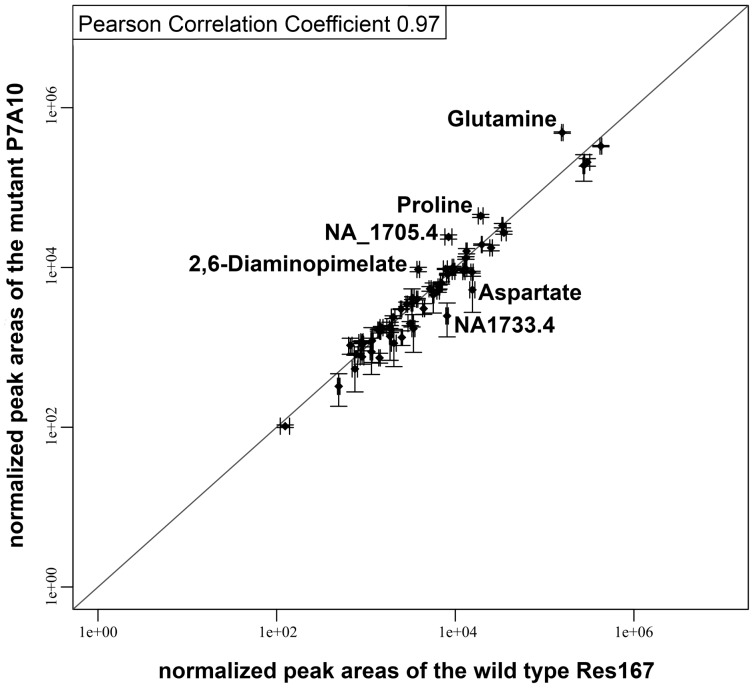
Metabolic profile of the C. glutamicum mutant P7A10.Scatter plot of normalized peak areas of the mutant P7A10 against the wild type Res167. Axes are logarithmically plotted. Only metabolites with changes >2 are labeled.